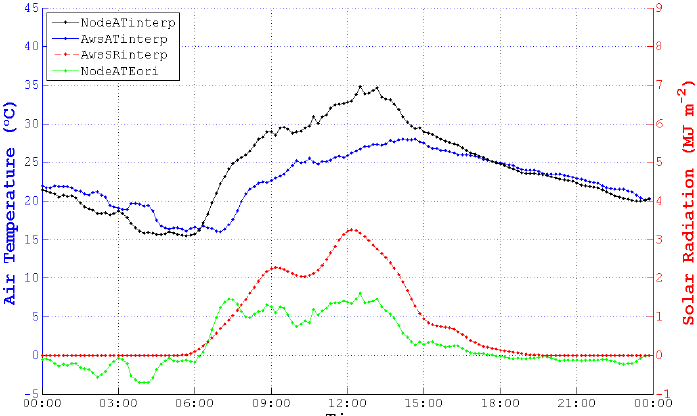
Figure 8. AT and SR after interpolating on 13 May 2014. NodeATinterp, AwsATinterp and AwsSRinterp are interpolated data corresponding to NodeAT, AwsAT and AwsSR. NodeATEori is the deviation between NodeATinterp and